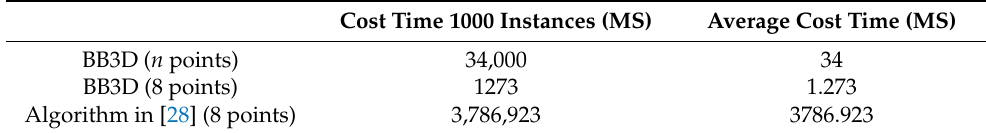
Table 4. Time consumption of bb3d for Q-Net.